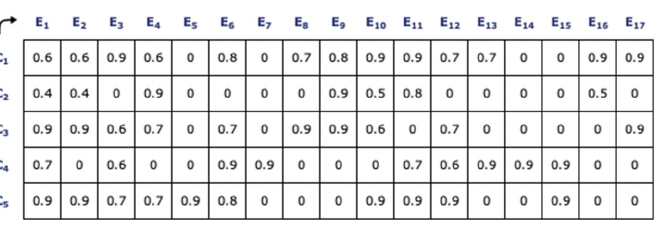
Figure A1. Matrix with a valuation of direct incidences between causes (C) and effects (E).